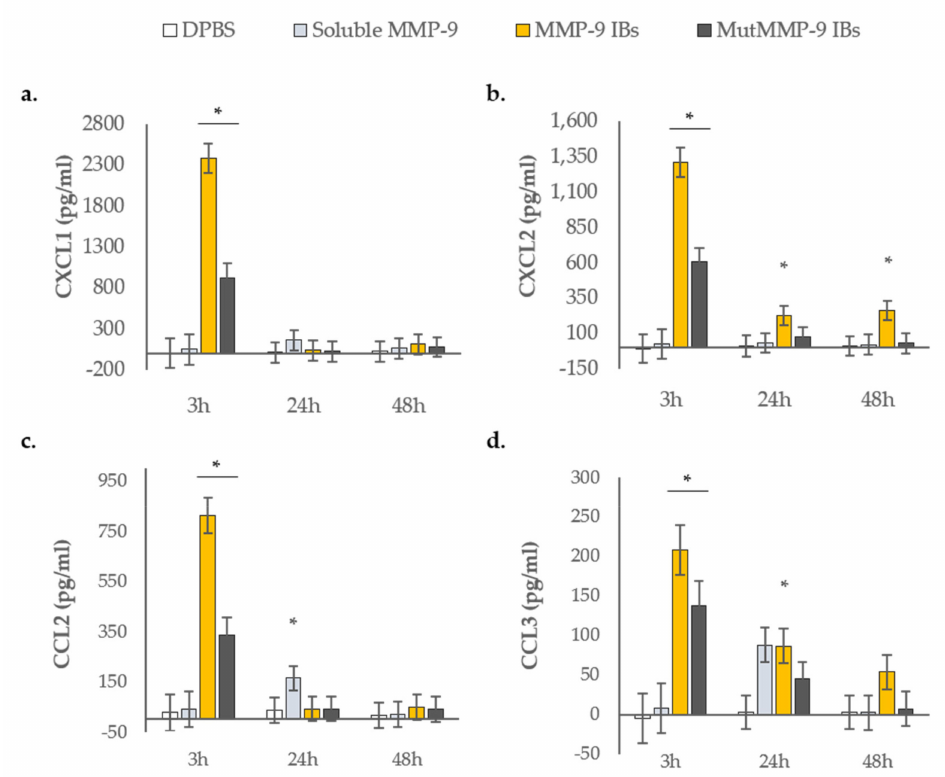
Figure 3. Pro-inflammatory chemokine concentrations in the recovered supernatants of the air pouches. ( a ) CXCL1; ( b ) CXCL2; ( c ) CCL2; ( d ) CCL3. Means and SEM (error bars) from non-transformed data are represented. Asterisks depict significant di ff erences ( p < 0.0001 in a , b , and c , and p < 0.005 in d ). Detailed di ff erences between treatments and time points represented by di ff erent letters can be found in Table S3 in the Supplementary